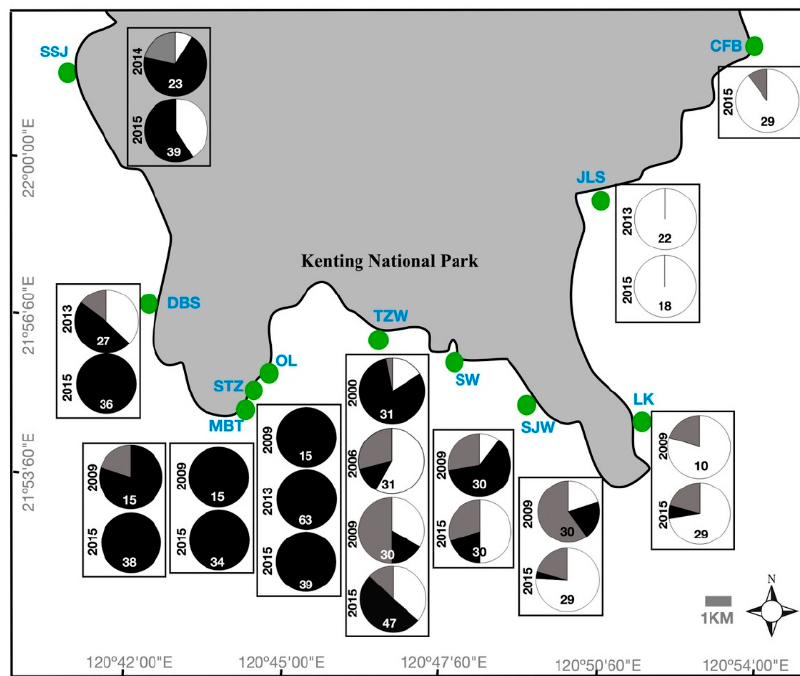
Figure 9. Spatial and temporal variation in Cloadopoium sp. and Durusdinium sp. data in the coral Isopora palifera from di ff erent locations—Siashuijue (SSJ), Dingbaisha (DBS), Maobitou (MBT), Siatanzai (STZ), nuclear power plant outlet (OL), Tanziwan (TZW), Shiaowan (SW), Siangjiaowan (SJW), Longkeng (LK), Jialeshuei (JLS), and Chufengbi (CFB) in Kenting National Park. The data were collected from 2000 to 2015 are adjacent to the pie-charts. Pie-Charts were drawn using data from previous publications (Hsu, C.-M etc. 2012; Fong, W.-L. 2016). Analysis of samples collected in 2000 was done using srDNA-RFLP and all the samples obtained between 2006–2015 were analysed by srDNA-RFLP and ITS2-DGGE (see Table 3) White = Cladocopium sp. (previously clade C), Black = Durusdinium sp. (previously clade D), and Grey = co-occuurence of Cladocopium sp. and Durusdinium sp. The values inside the pie-charts are total sample numbers for every location.